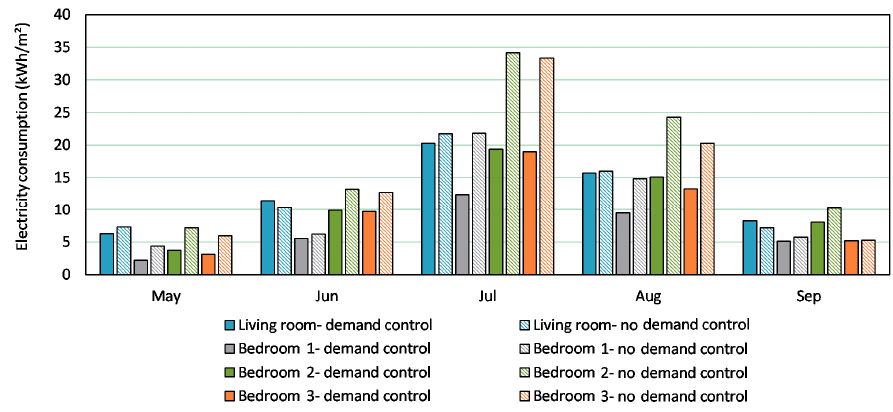
Figure 29. The electricity consumption of each room with / without demand control in summer.